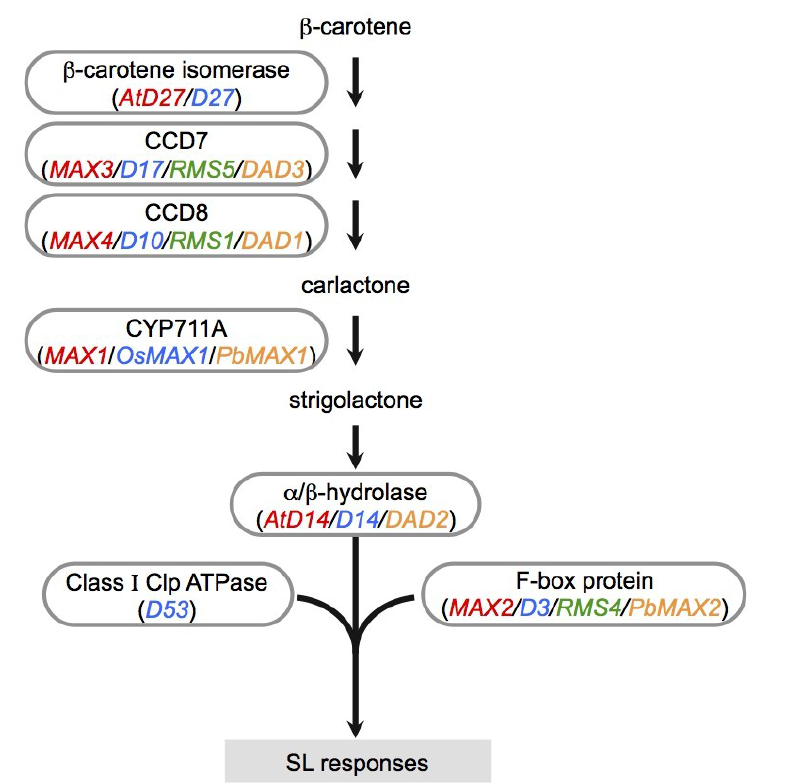
Figure 2. SL biosynthesis and signaling pathway. The SL precursor carlactone is produced from β-carotene by three enzymes, β-carotene isomerase, CCD7, and CCD8. MAX1 is CYP711A, a member of the cytochrome P450 family, and acts as an oxidase for conversion of CL to SL. D14 (α/β-hydrolase) and F-box protein form an SCF-type ubiquitin ligase complex required for SL signaling. D53 is targeted for degradation by the SCF complex in SL signaling. Gene color coding: red, Arabidopsis; blue, rice; green, pea; orange,